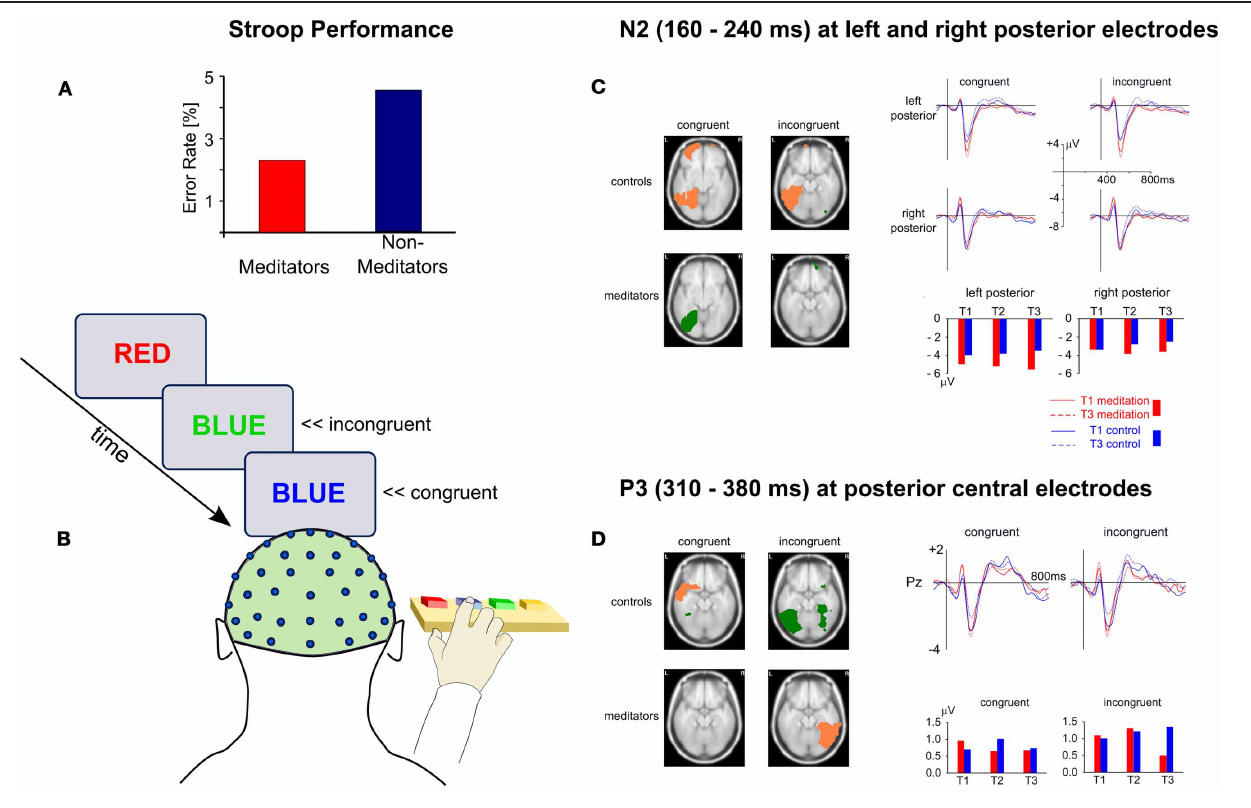
components. The glass brain slices show activation differences between T1 and T3 for each group and congruency. Salmon-colored areas indicate a decrease in activation and green areas indicate activation increase. On the right hand side ERPs (line graphs) and ERP-component amplitudes (bar graphs) are depicted for left and right posterior sites (C) and for posterior central sites (D)